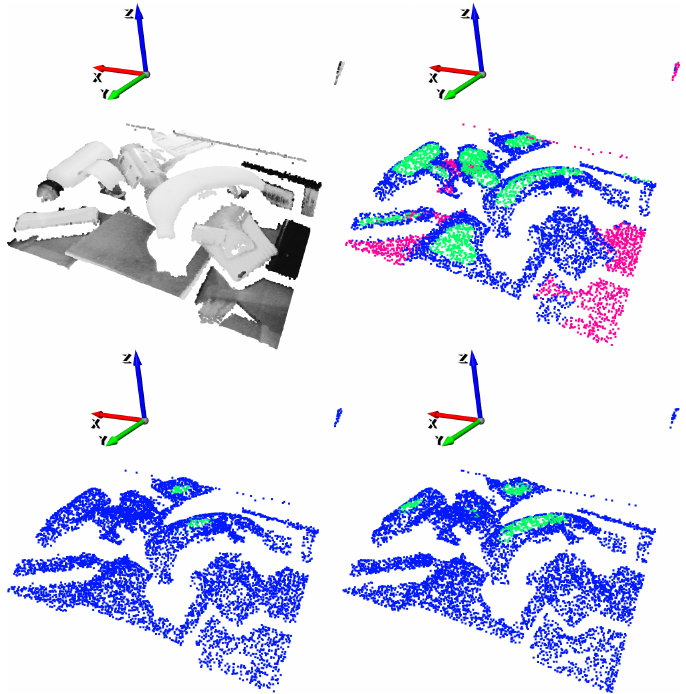
Figure 17. Suction result example with totally new objects. Top-left: point cloud of the scene. Top-right: ground-truth annotation. Bottom-left: top-1% predictions. Bottom-right: top-5% predictions.